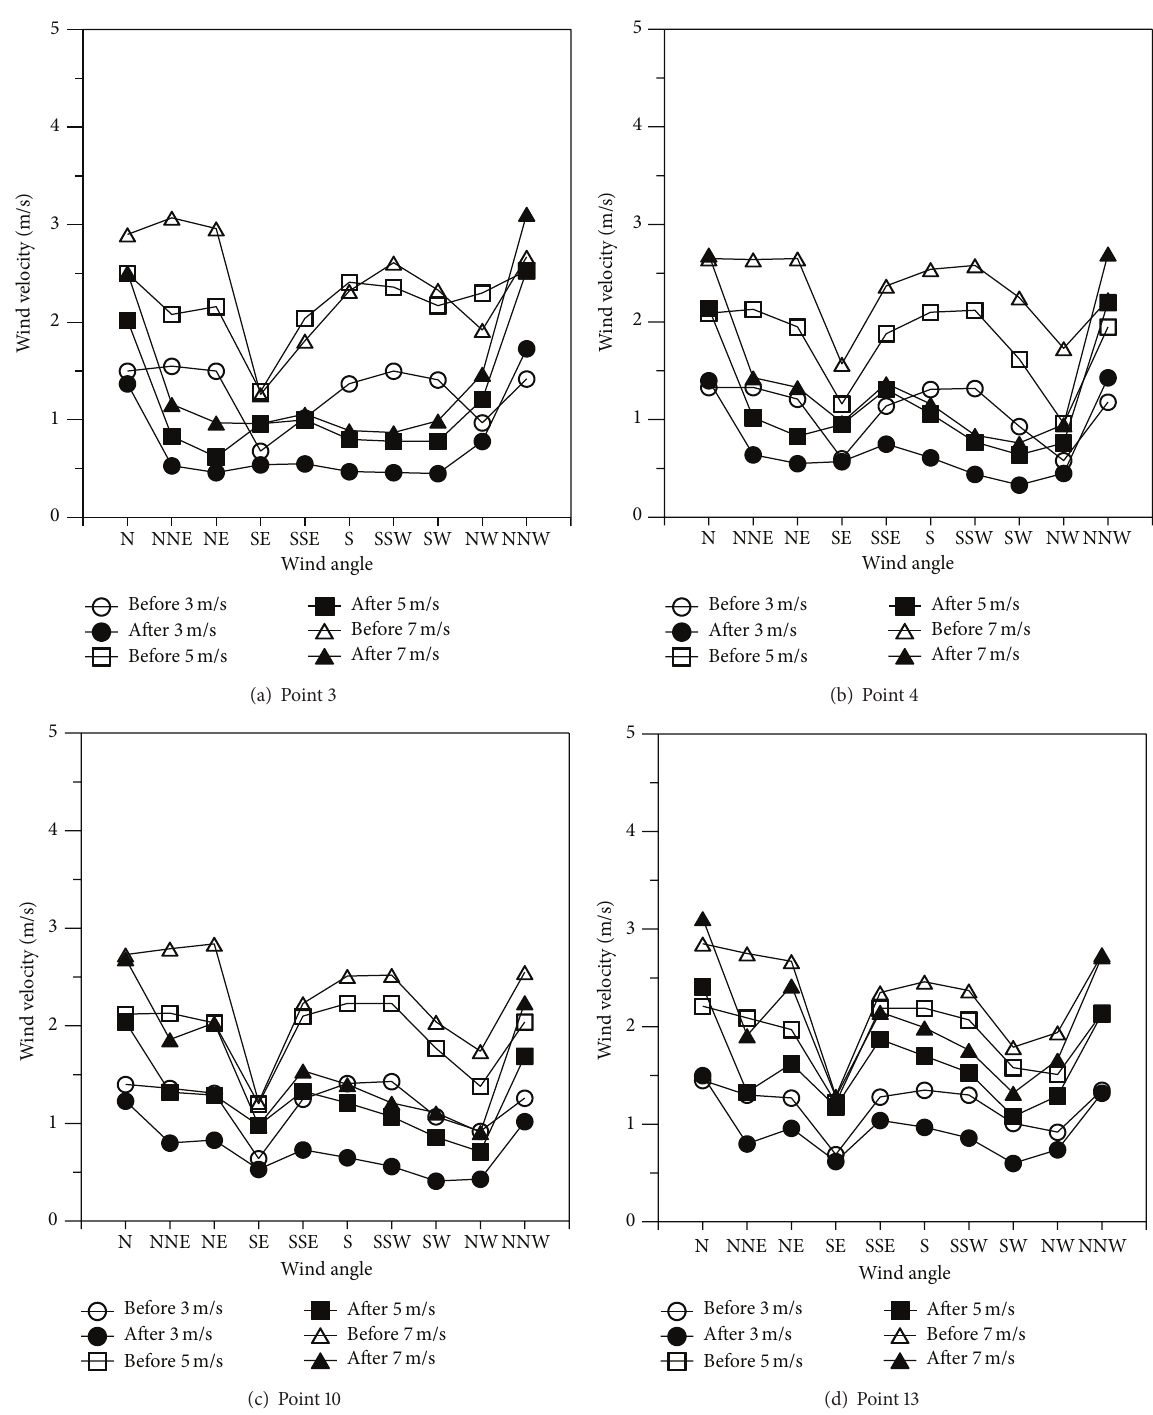
Figure 5: Distribution of wind velocities by measurement site according to wind angle changes in area to right of embankment.